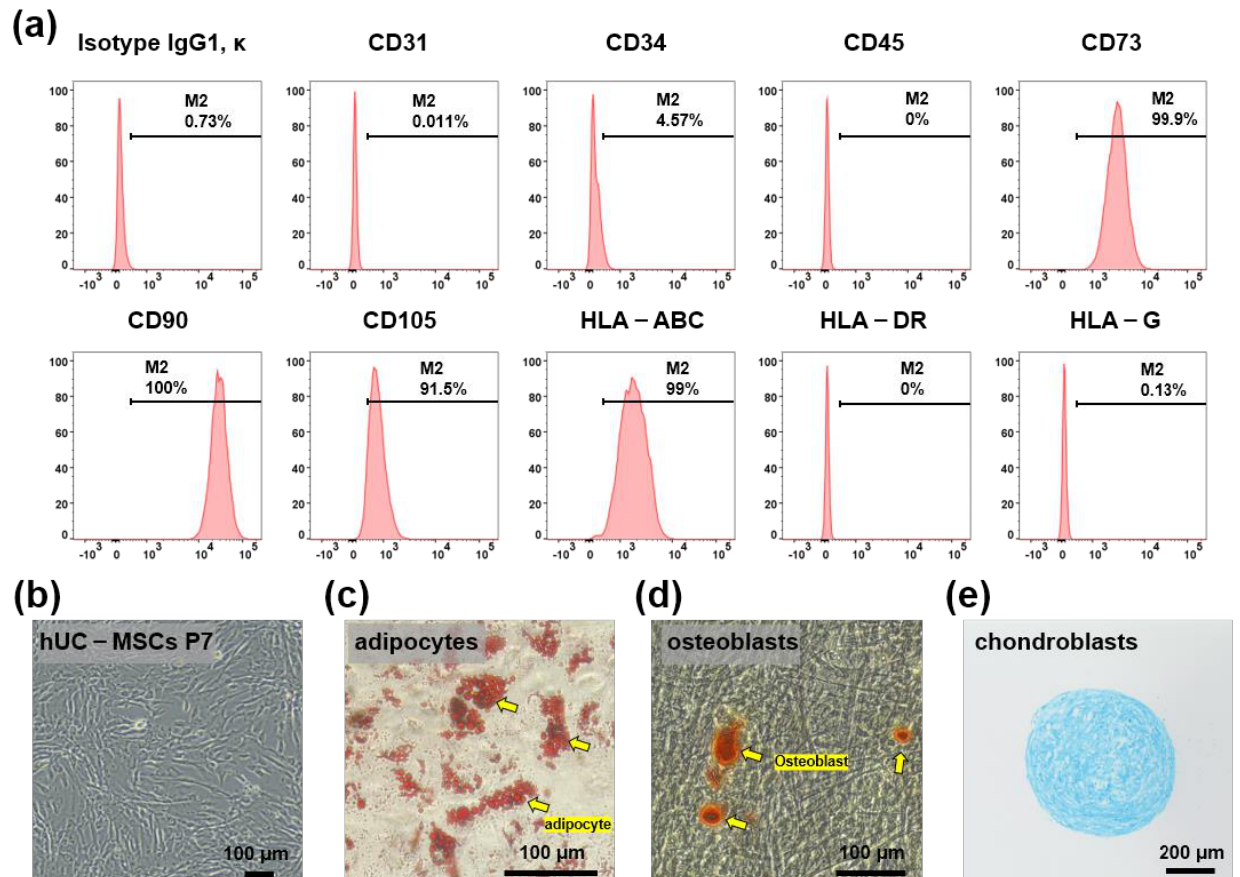
Figure 1. Characterization of human umbilical cord mesenchymal stem cells (hUC-MSCs). ( a ) Flow cytometry analysis using hUC-MSCs surface markers CD31, CD34, CD45, CD73, CD90, CD105, HLA-ABC, HLA-DR, and HLA-G. ( b ) Bright-field microscopic images show spindle-like hUC-MSCs. Scale bar = 100 μm. ( c – e ) Differentiation ability of hUC-MSCs. Adipocytes, osteoblasts, and chondrocytes were detected using Oil Red O, Alizarin Red, and Alcian Blue, respectively, scale bar = 100 μm, 100 μm, and 200 μ m, respectively.